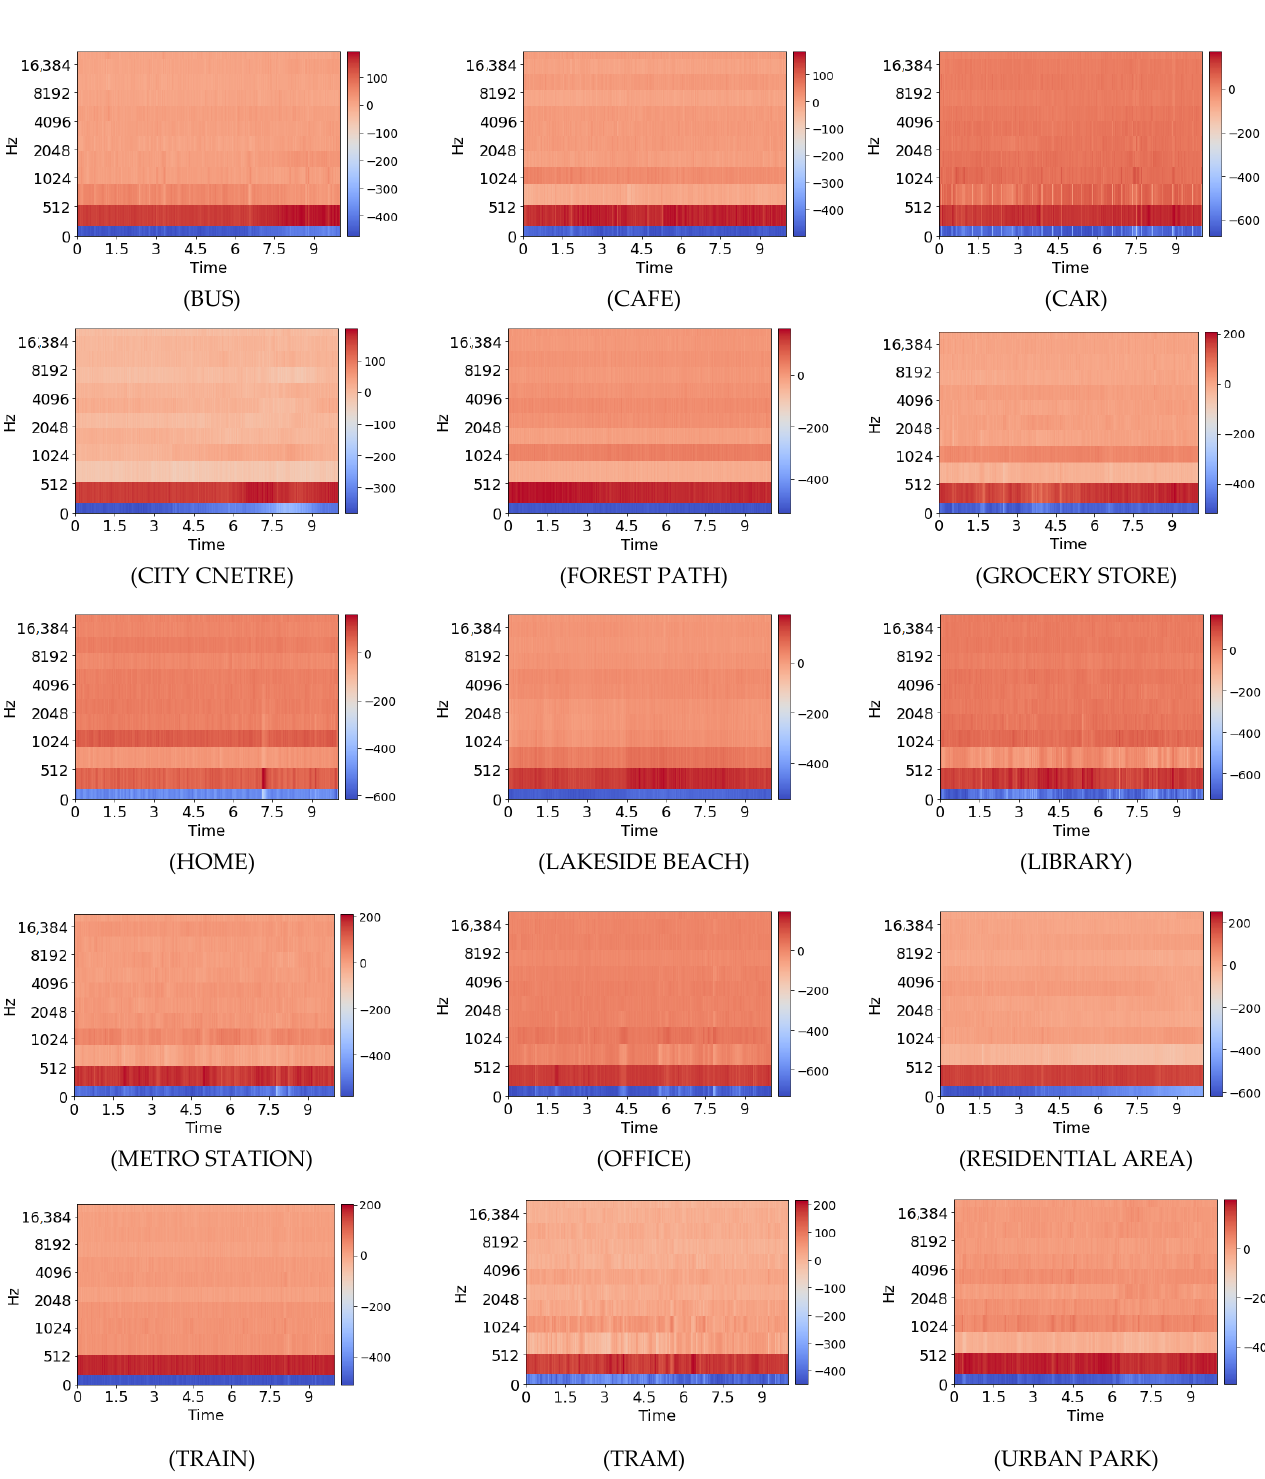
Figure 3. Plot of Mel frequency cepstral coefficient (MFCC).